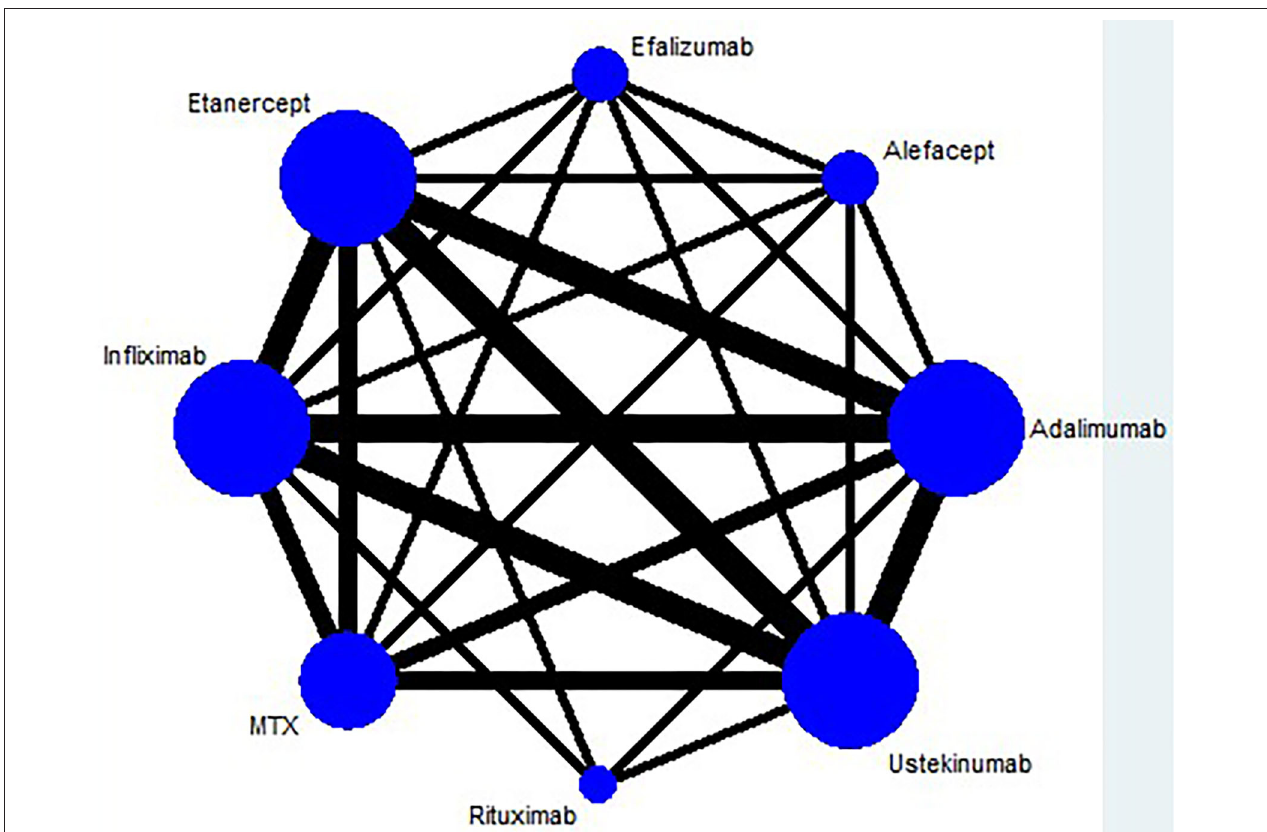
FIGURE 3 | Network plots of network